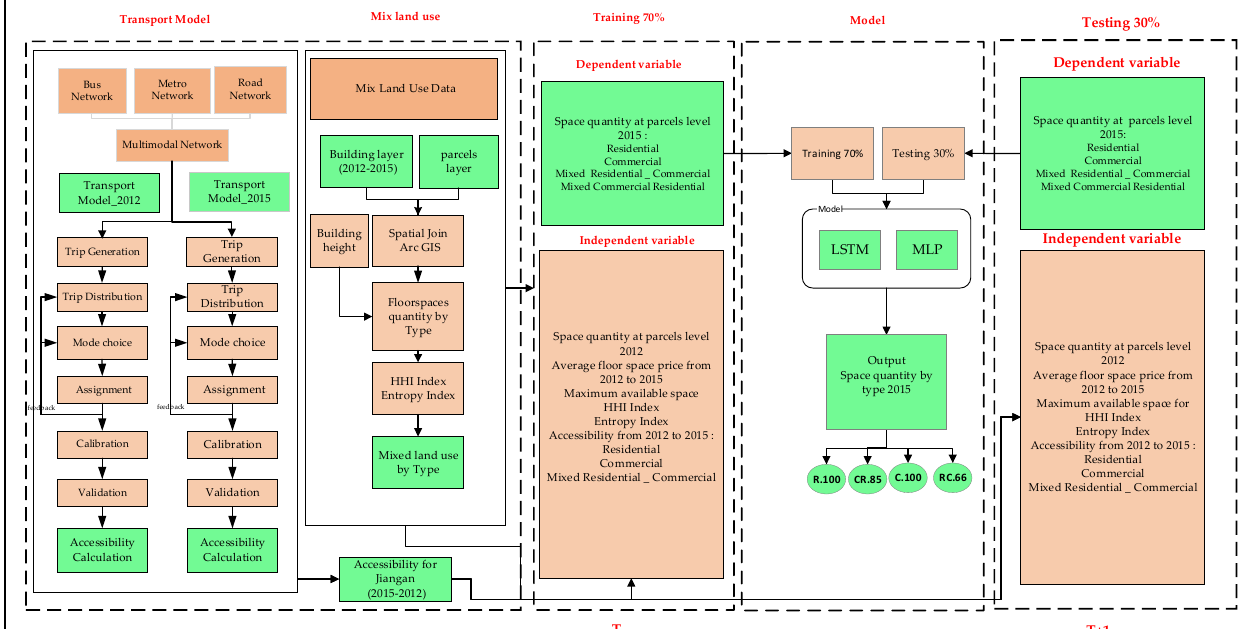
Figure 6. The workflow of the proposed model.